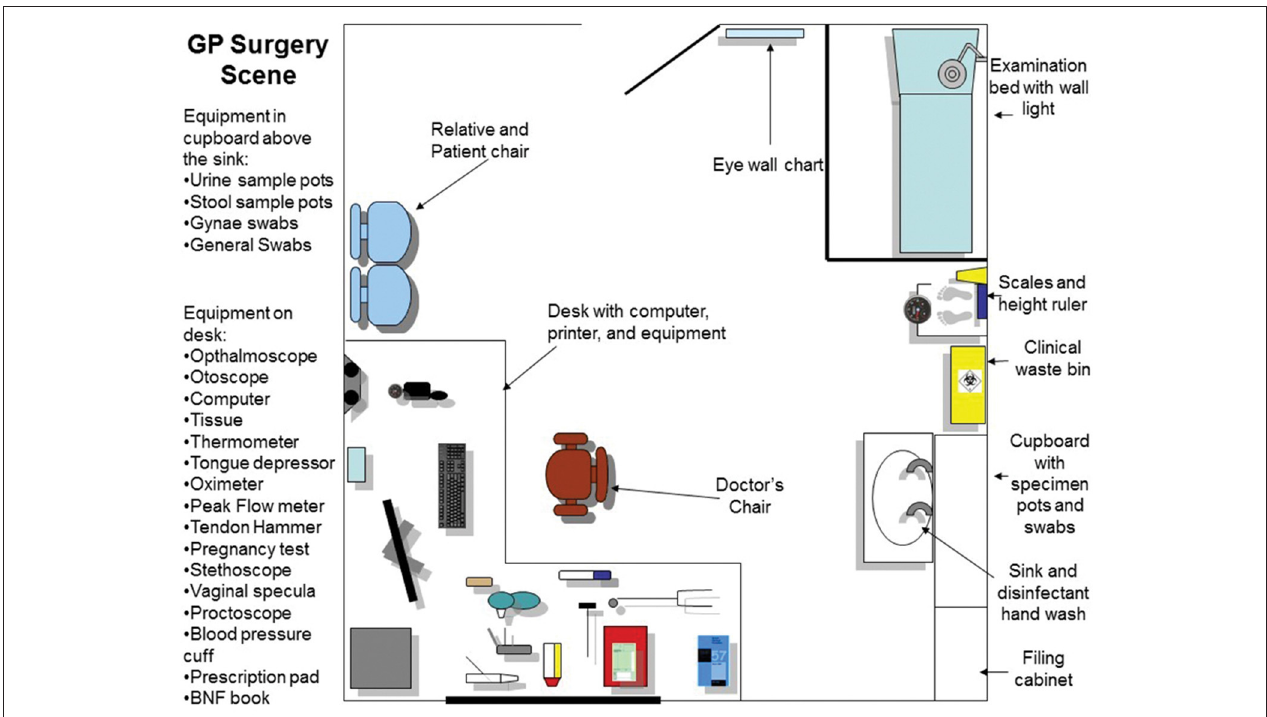
FIGURE 1 | The plan of the GP surgery room. This map was used both as a design for the 3D world, and as a guide to inform students and facilitator which equipment can be found within the scenario, and its